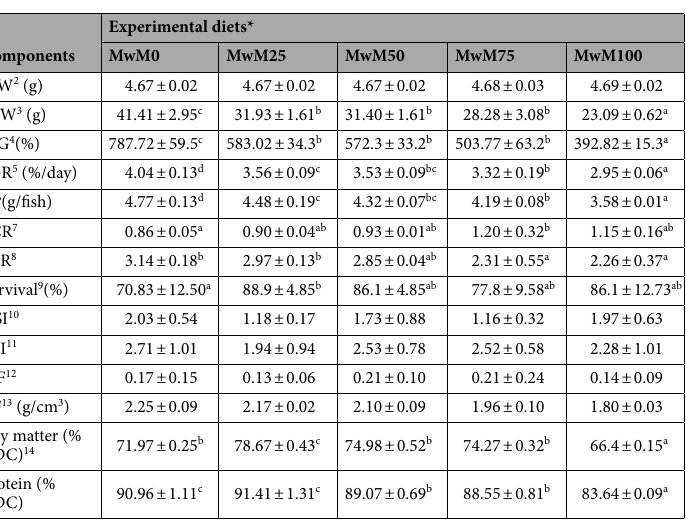
Table 4. Growth performances, feed utilization efficiency, Somatic indexes, condition factor and apparent digestibility coefficient (% dry matter) of tilapia fed increasing dietary levels of mealworm meal 1 . *MwM denotes mealworm meal. The number following the letters denotes the % of MwM added, for each diet. 1 Values are the mean ± S.E. of triplicate groups of fish. Values with different superscript letters in each row are significantly different (P < 0.05). The lack of superscript letters indicates no significant differences among treatments. 2 Initial Body Weight (g). 3 Final Body Weight (g). 4 Expressed as the percent of initial body weight at the end of 8 weeks. 5 Specific growth rate (% day −1 ) = 100 × (ln final − ln initial fish weight)/days. 6 Feed Intake (g/fish) = total dry feed intake/number of fishes over 54 days. 7 Feed conversion ratio = total dry diet fed (g)/ wet weight gain (g). 8 Protein efficiency ratio = wet weight gain (g)/total protein intake (g). 10 Hepatosomatic Index (HSI) = 100 × [liver weight (g)/body weight (g)]. 11 Viscerosomatic index (VSI) = 100 × [viscera weight